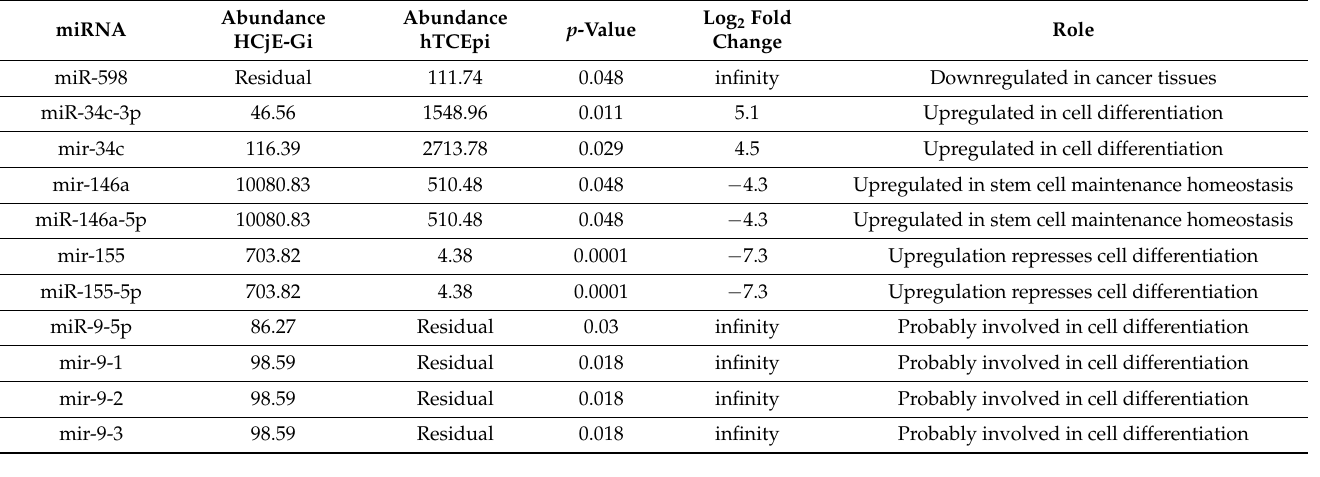
Table 1. Next-generation sequencing (NGS) assessment of the samples showing miRNA content of the two exosome populations. Mir denotes precursor miRNA molecules, miR denotes mature miRNA molecules.